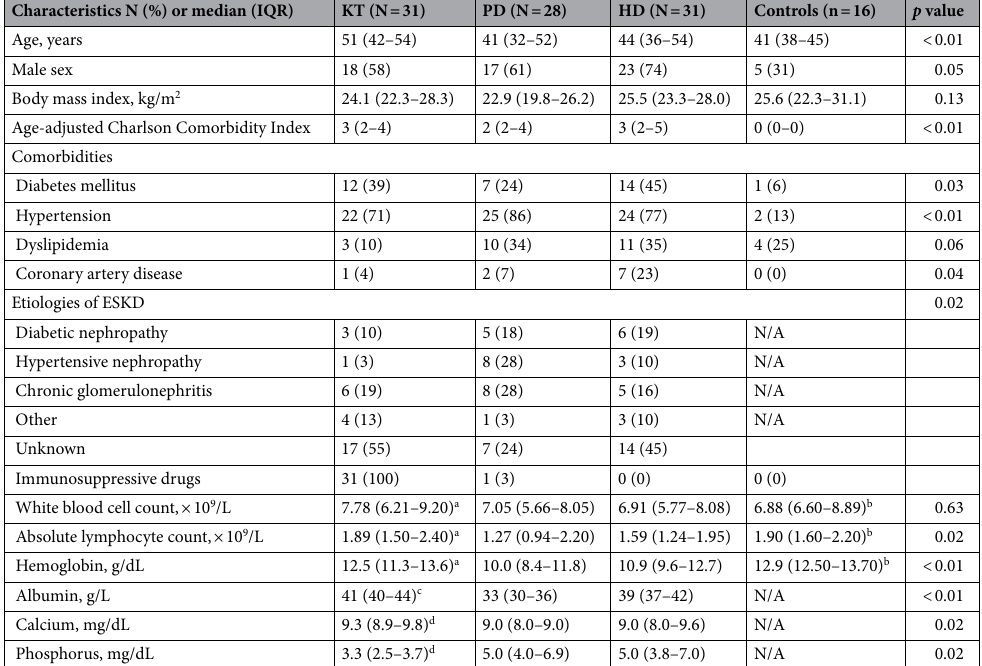
Table 1. Clinical characteristics of the study participants. ESKD end-stage kidney disease, HD hemodialyzed patients, IQR interquartile range, KT kidney transplant recipients, N number, N/A not applicable, PD peritoneal dialyzed patients. a Evaluated in 27 participants. b Evaluated in 9 participants. c Evaluated in 25 participants. d Evaluated in 23